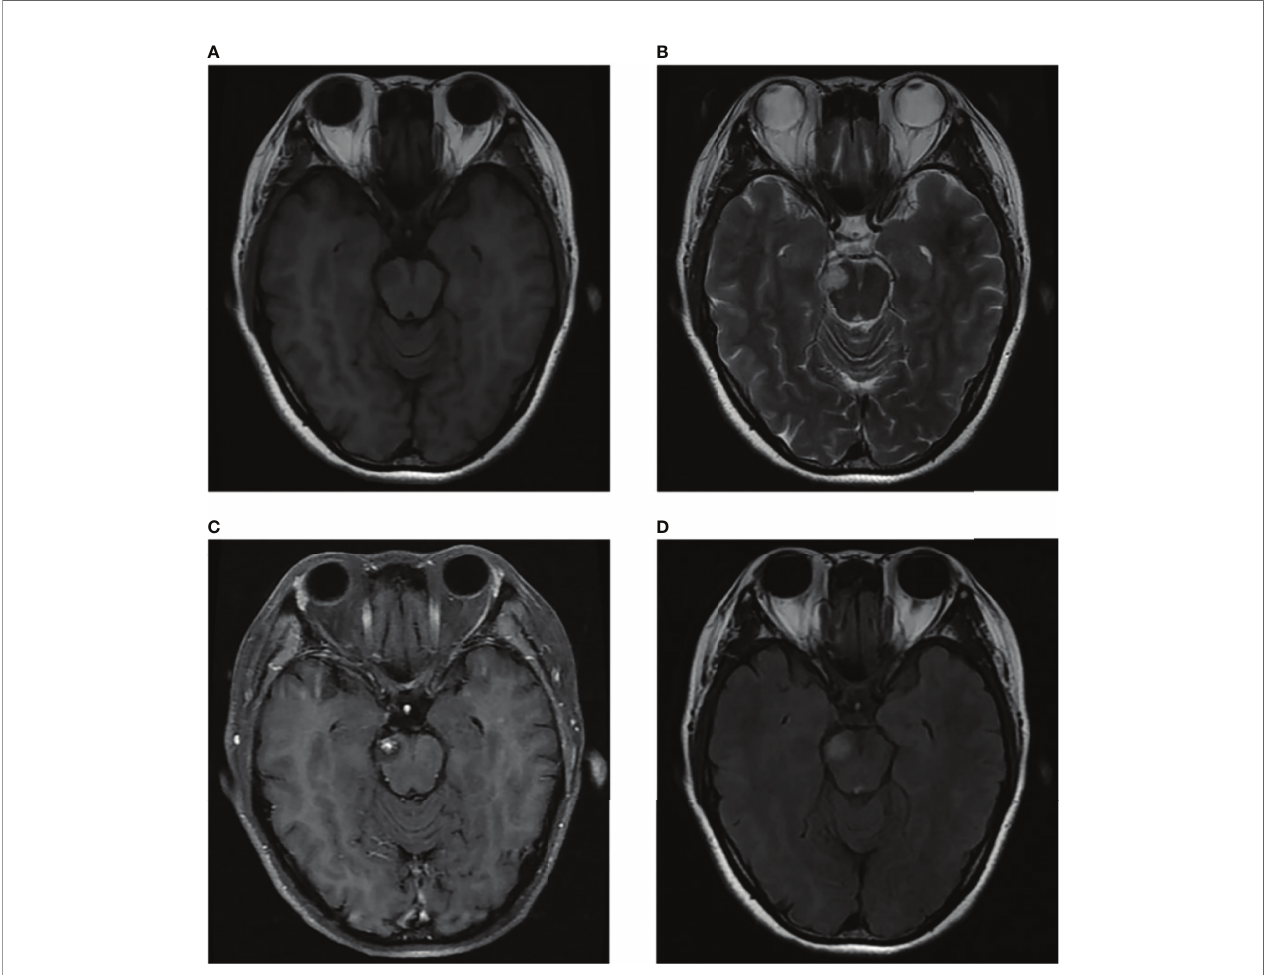
FIGURE 1 | MRI scans showed a well-de fi ned irregular mass in the pons (B) . The mass showed slight hyperintensity on T2-weighted MR images and FLAIR images (B, D) and comparatively lower intensity on T1-weighted MR images (A) . Contrast-enhanced MR image showed prominent heterogeneous enhancement of the lesion, presenting central enhancement (C) ( Figure 3A ). The bottom is located lateral to the pons. The excised lesion appeared as a brown soft tissue mass.